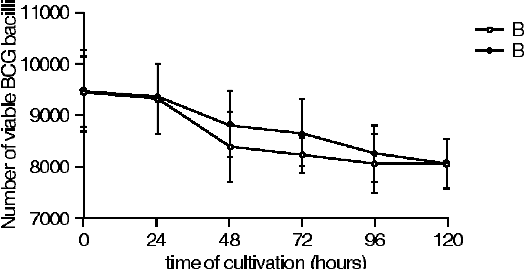
FIG. 4. Growth inhibition of BCG bacilli in peritoneal macrophages. Groups of five mice were sacrificed and their peritoneal macrophages collected and infected with 1.5 ´ 106 colony-forming units of BCG-I or BCG-S. At different times the number of intracellular bacilli was assessed as described in Materials and Methods. Each point represents the values of samples from five experiments ± standard deviation in different groups of five